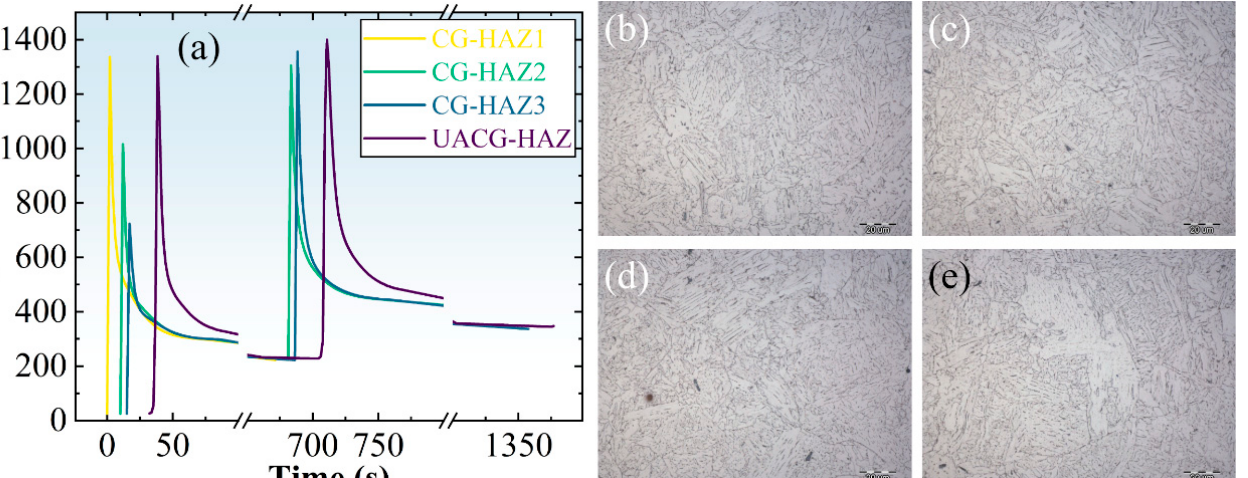
Figure 11. Thermal process of SCRCG-HAZ and the thermal simulation microstructures (with a magnification of 500): ( a ) thermal cycles calculated for thermal simulation of SCRCG-HAZ; ( b ) mi- crostructures of thermal simulated SCRCG-HAZ.